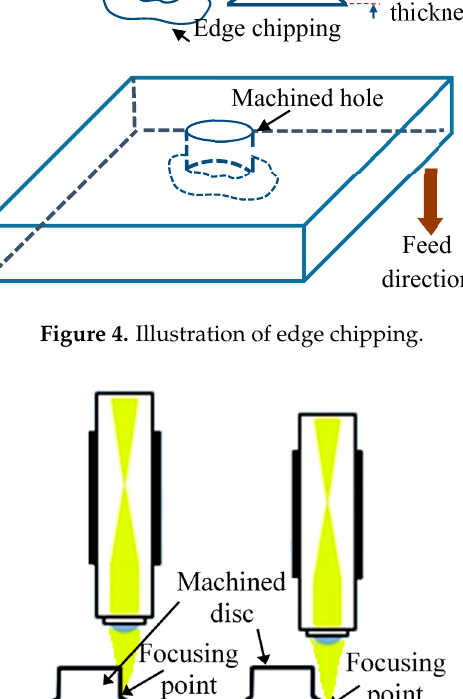
Figure 5. Illustration of the measurement of chipping size (thickness) on a microscope.